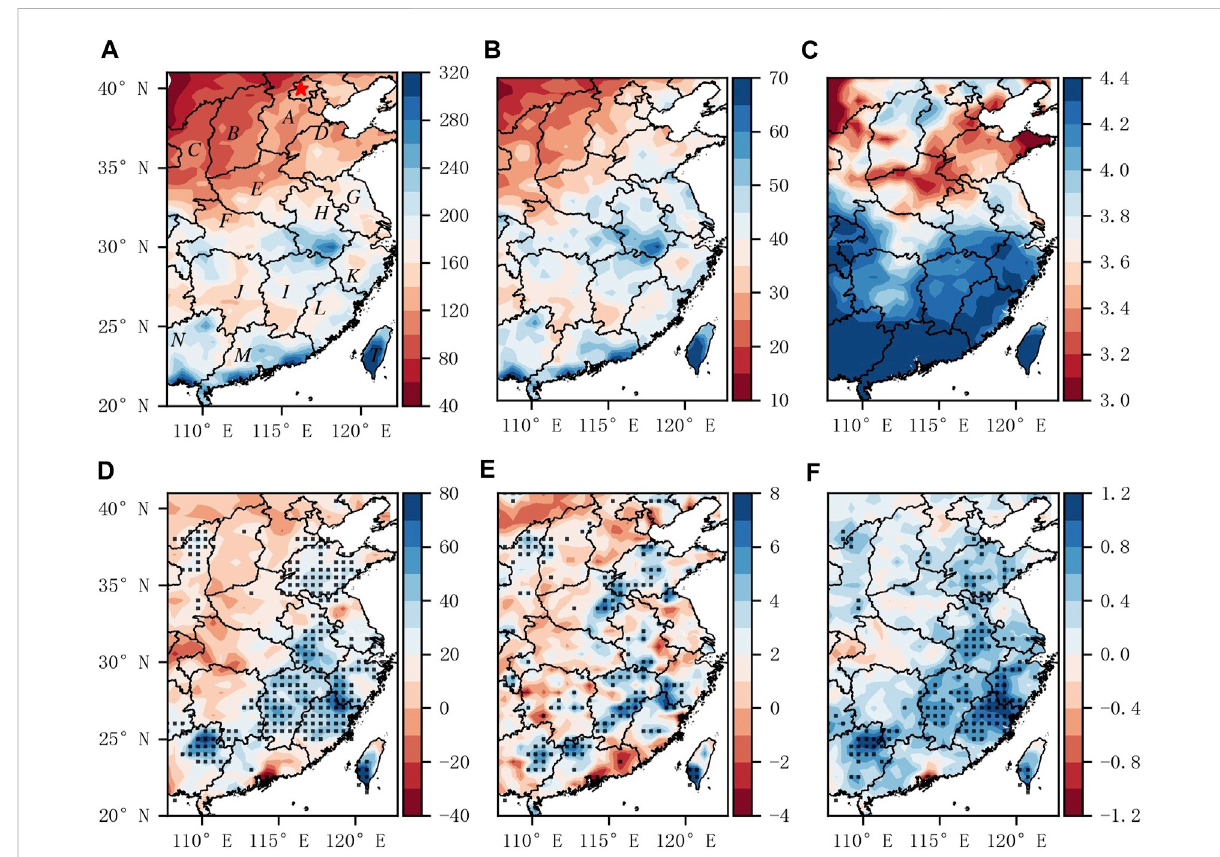
FIGURE 1 Eastern Chinainthesummers from 1979to 2020: extreme precipitationamount (A) (units: mm); extreme precipitation intensity (B) (units:mm/ d); extreme precipitation frequency (C) (units: (D) ; linear trend of extreme precipitation amount (D) (units: mm ( 10a ) − 1 ); linear trend of extreme precipitation intensity (E) (units: mm/d ( 10a ) − 1 ); linear trend of extreme precipitation frequency (F) (units: d ( 10a ) − 1 ). Dotted areas indicate values exceedingthe95%con fi denceleveldeterminedbyusingFtest.RedstarrepresentsBeijing,A-Trepresentindividualprovinces:Hebei(A),Shanxi (B), Shaanxi (C), Shandong (D), Henan (E), Hubei (F), Jiangsu (G), Anhui (H), Jiangxi (I), Hunan (J), Zhejiang (K), Fujian (L), Guangdong (M), Guangxi (N), Taiwan